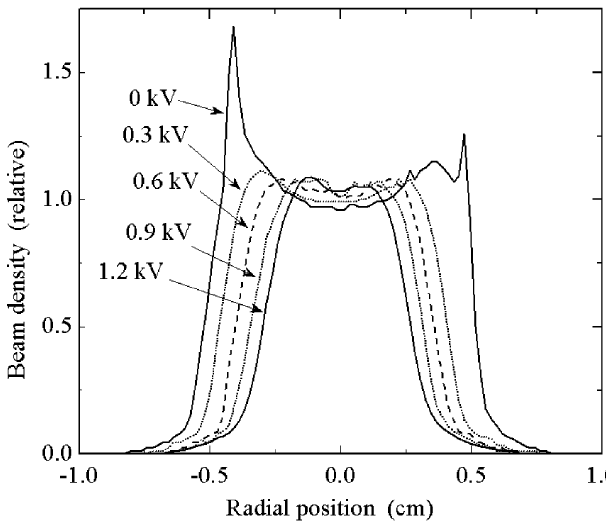
FIG. 12. The electron current-density profile generated by the flat gun at different voltages U The anode-cathode voltage U all solenoids is 2 kG.